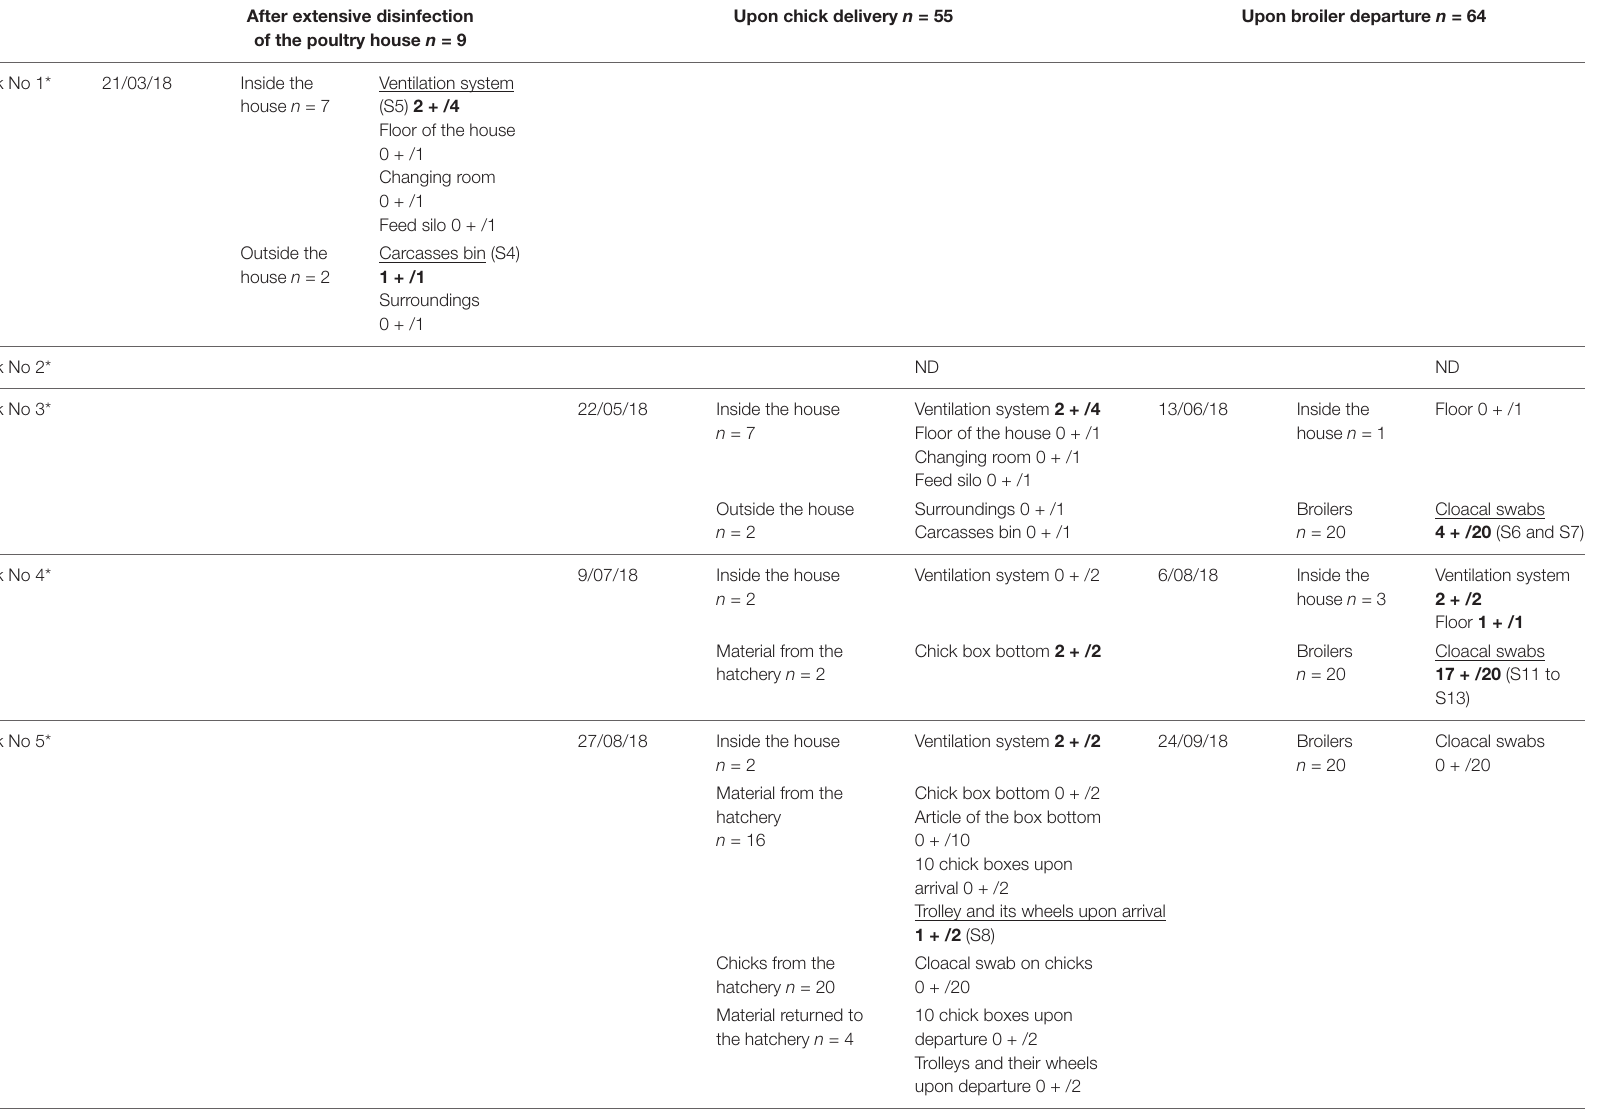
TABLE 2 | Detection of C. botulinum type D/C in the poultry house after the cattle outbreak ( n = 128) using swab samples. After extensive disinfection Upon chick delivery n = 55 Upon broiler departure n = 64 of the poultry house n = 9